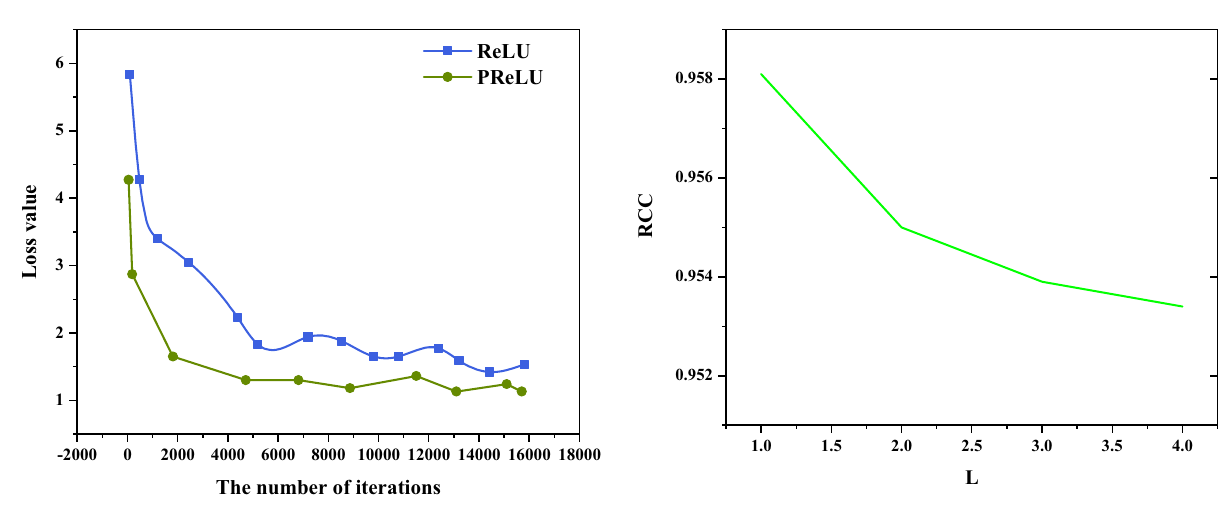
Figure 6: P – M di ff usion ( CORR ) based on gradient automatic threshold estimation.